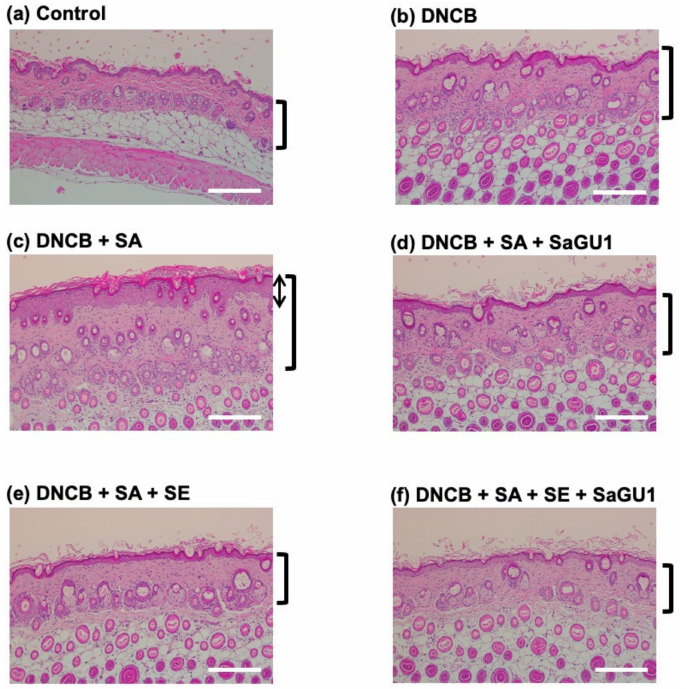
Figure 6. Histopathological features of skin lesions of group B mice. AD pathology was induced by DNCB in back skin specimens, and then, staphylococci and phage were applied. Tissues were excised on day 5. The sections were stained with hematoxylin-eosin. ( a ) Control, no DNCB sensitization and no S. aureus SA-1 painting; ( b ) with DNCB sensitization and no S. aureus SA-1 painting; ( c ) with DNCB sensitization and S. aureus SA-1 painting; ( d ) with DNCB sensitization, S. aureus SA-1 painting, and SaGU1 administration; ( e ) with DNCB sensitization, S. aureus SA-1 painting, and S. epidermidis SE-4 administration; ( f ) with DNCB sensitization, S. aureus SA-1 painting, and administration of both S. epidermidis SE-4 and SaGU1. Scale bars correspond to 200 µ m. Square brackets on the right indicate epidermis thickness, and the arrow in ( c ) indicates the thickness of the stratum